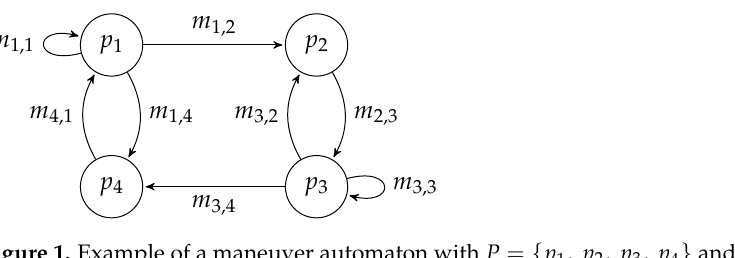
Figure 1. Example of a maneuver automaton with P = { p 1 , p 2 , p 3 , p 4 } and M = { m 1,1 , m 1,2 , m 1,4 , m 2,3 , m 3,2 , m 3,3 , m 3,4 , m 4,1 }